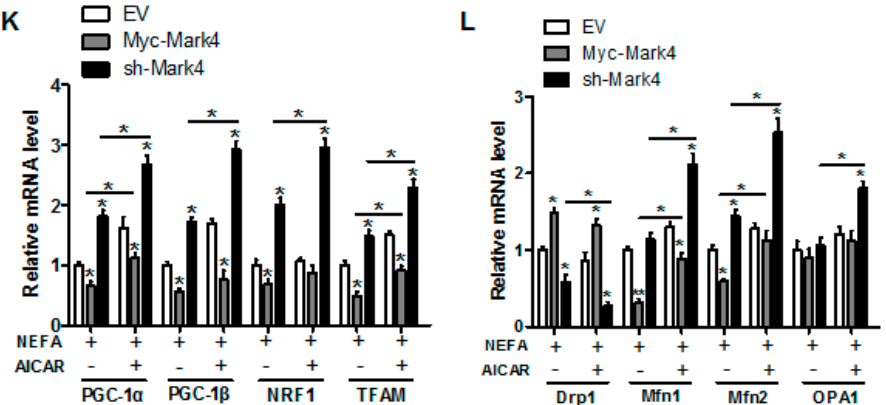
Figure 5. Inhibition of the AMPK pathway by MARK4 blocks mitochondrial function and mitochon- drial biogenesis in pig primary trophoblast cells challenged with 400 µ M NEFA. ( A , B ) Representative immunoblots and densitometric quantification for MARK4, AMPK, and phos-AMPK after transfection with Myc-MARK4 and sh-MARK4 for 48 h in cytotrophoblasts. Cells were then treated with 400 μ M NEFA or 1 mM AICAR for 24 h ( n = 3). ( C ) Relative activity of ROS, SOD, CAT, and GSH-PX after transfection with Myc-MARK4 and sh-MARK4 for 48 h in trophoblast cells. Before the assessment, cells were incubated with 400 μ M NEFA or 1 mM AICAR for 24 h ( n = 3). ( D ) mRNA levels of genes implicated in oxidant stress ( n = 3). Results were expressed as fold change relative to the values of control cells set to 1 unit. ( E , F ) The activity of mitochondrial complexes I ( E ) and III ( F ) in pig trophoblast cells ( n = 3). ( G , H ) Mitochondrial biogenesis was estimated by both mtDNA copy number ( G ) and CS activity ( H ) in primary trophoblast cells ( n = 3). ( I ) Representative immunoblot analysis of mitochondrial complexes I (NDUFB8), II (SDHB), III (UQCRC2), and V (ATP5 α ). ( J ) Densitometric analysis of corresponding proteins in ( I ) by normalization to GAPDH as an internal con- trol ( n = 3). ( K , L ) Relative mRNA expression of genes implicated in mitochondrial biogenesis ( K ) and mitochondrial fission and fusion ( L ) in cytotrophoblasts. Results are expressed as mean ± SEM. * p < 0.05 compared with the control group. ROS: reactive oxygen species; NEFA: non-esterified fatty acid; AICAR: AMPK agonist; Myc-MARK4 group: over expression of MARK4 group; sh-MARK4 group: knock down of MARK4 group; Control: empty vector (EV) group.